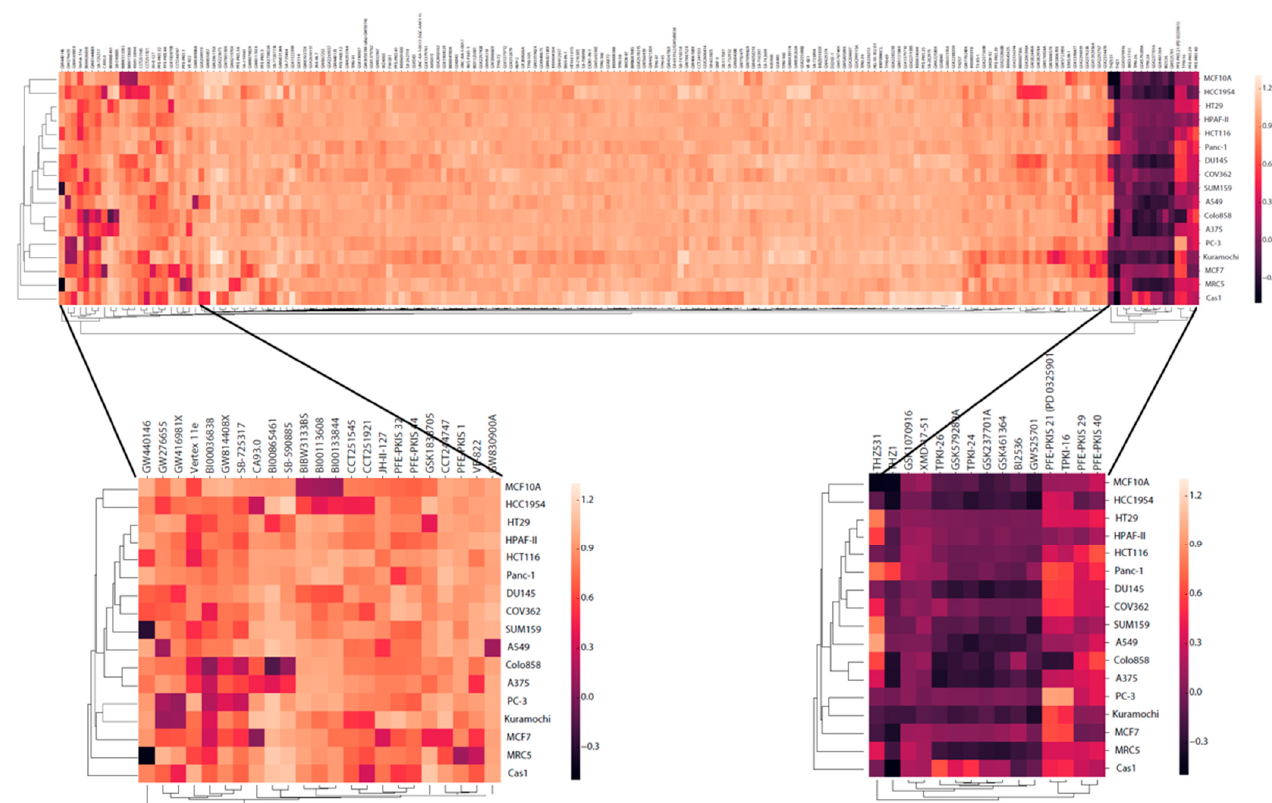
Figure 5. The kinase inhibitors in KCGS have different effects on cell growth across a wide range of lines. Normalized growth rate (GR) inhibition values were determined at 72 h post compound treatment. Each row displays data from a single cell line. Each column displays data from a single compound. GR is colored from − 0.5 in black to 1.3 in yellow. The expanded views display data for compounds that showed cell-line selective decrease in GR and relatively cell-line independent effects, respectively.